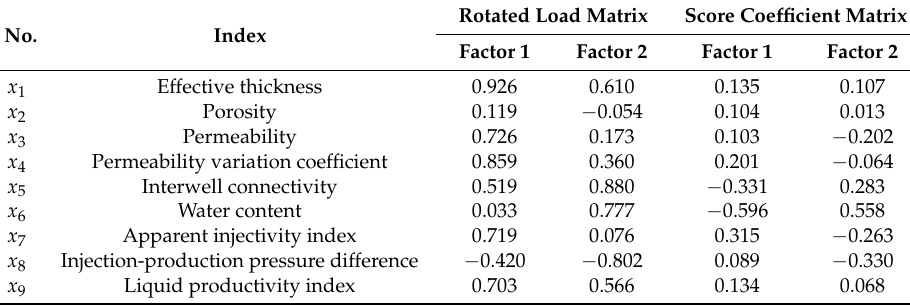
Table 5. Rotated load matrix and score coefficient